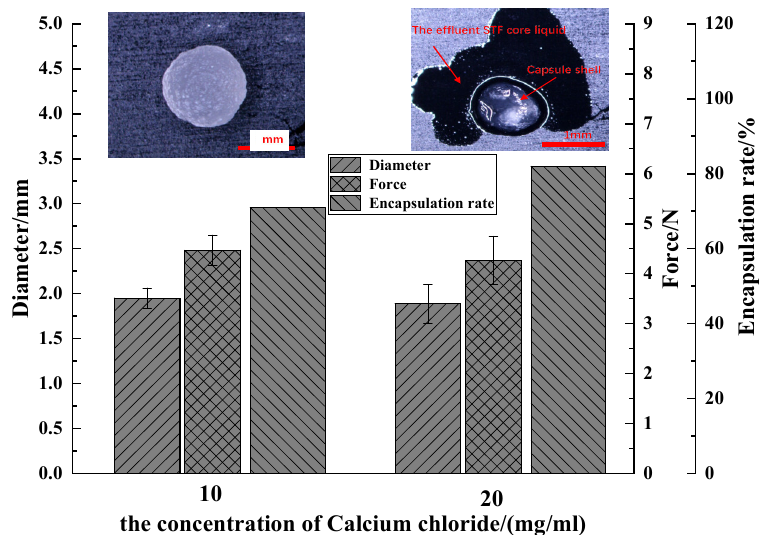
Figure 5. Comparison of the diameter distribution, strength and encapsulation rate of the capsules as related to the concentration of calcium chloride.